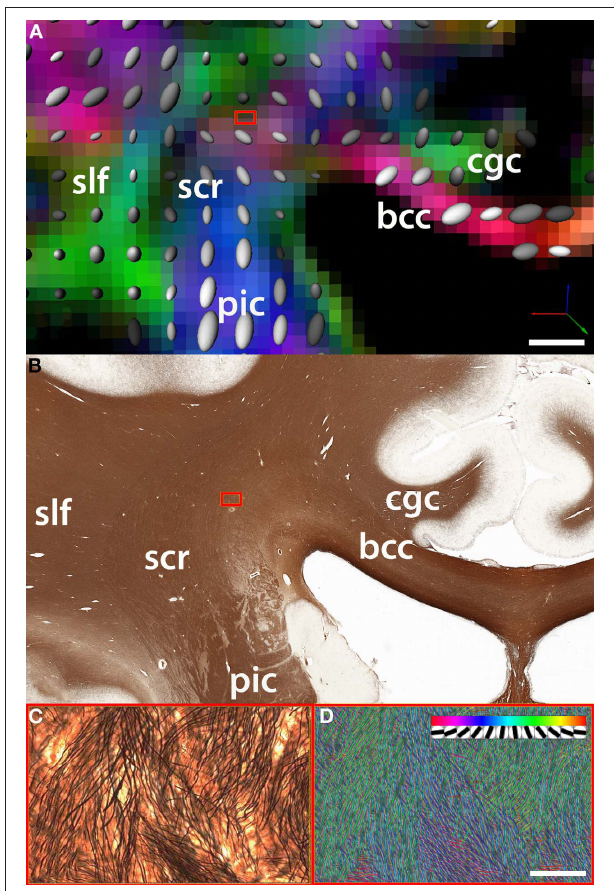
FIGURE 2 | Comparison between (A) fiber orientation maps derived from DTI and (B) the underlying myelo-architecture in the region of intersection of the fibers belonging to the corpus callosum (cc) which travel along the coronal plane (parallel to the plane of the figure) and the superior corona radiata (scr). In this example, the region of intersection between cc fibers and the scr is an area that shows significant crossing over of fibers of small caliber (blue box). (C) One DTI voxel-wide selection from silver-stained tissue slice (magnification = 20 × ). (D) The density and orientation of single white matter fibers is quantified using a template matching algorithm [Bartsch et al. (2011)]. The insert in panel D shows the discrete orientations of the templates used to classify fiber bundles. DTI acquisition parameters: image matrix size = 96 × 96, B 0 = 1000, 51 directions, FOV = 24cm, 47 axial slices, slice thickness = 2.5mm. Fiber track definition derived from the atlas of Oishi and colleagues (2011); bcc: body of the corpus callosum; cgc: cingulum; slf: superior longitudinal fasciculus. Scale bars: Panel B = 5mm; Panel C = 100